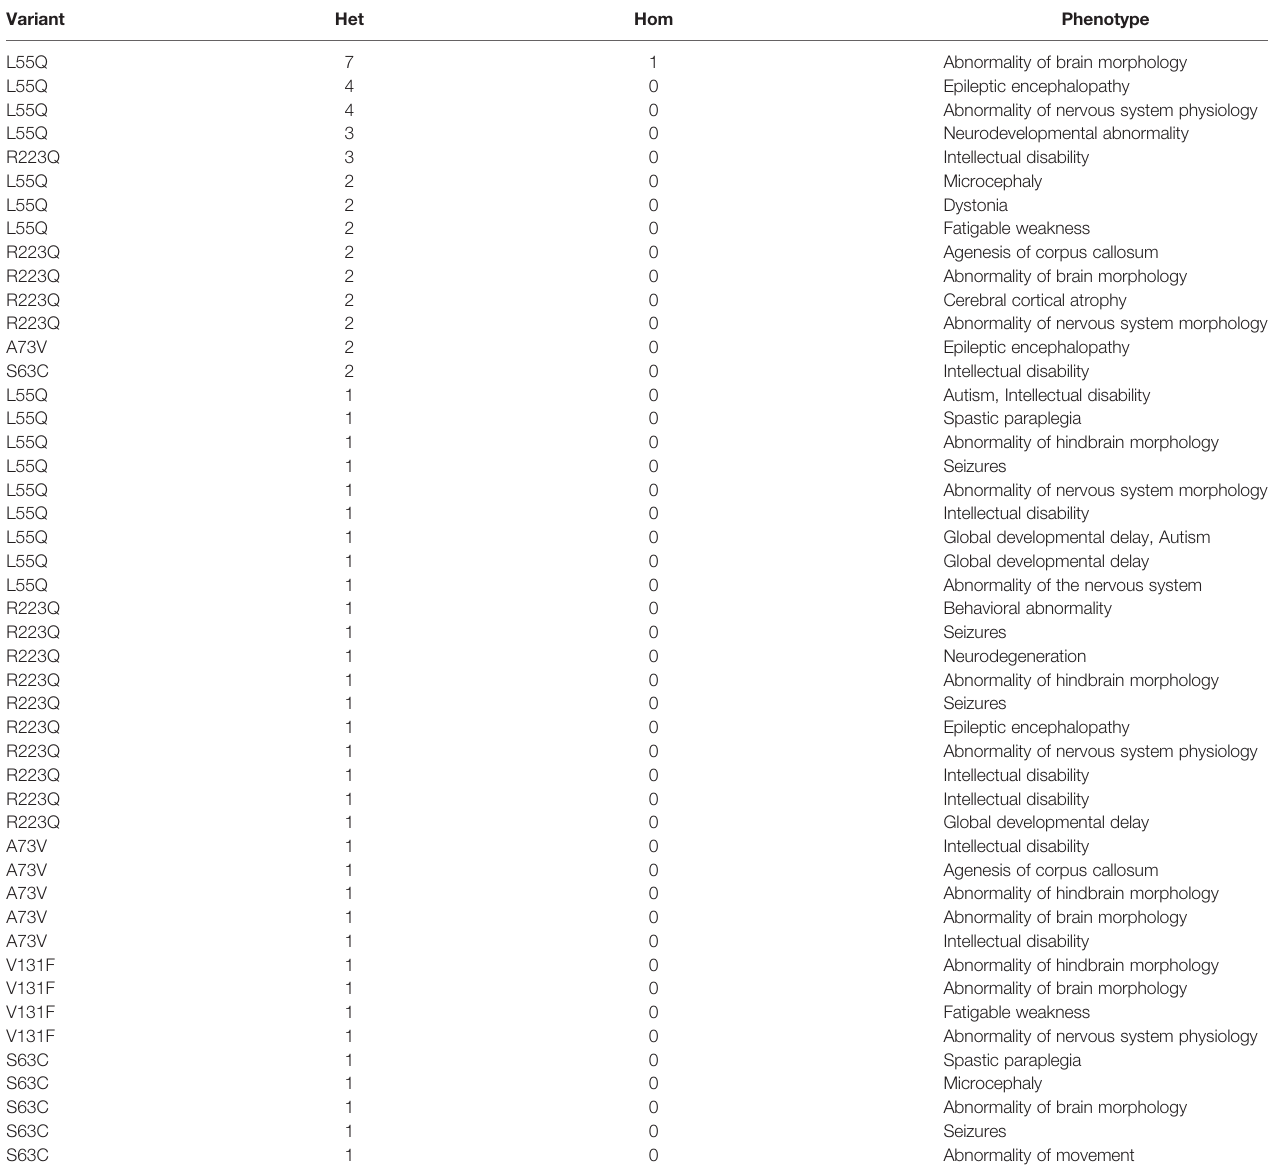
TABLE 5 | Neurological phenotypes for the top human CCR5 missense variants from Geno2MP. Variant